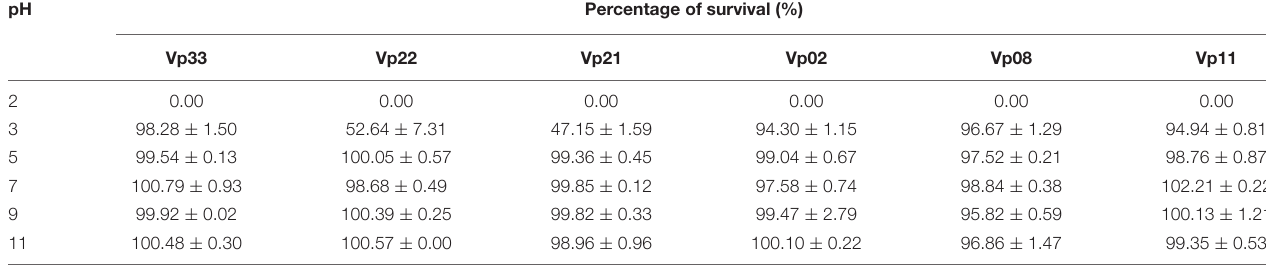
TABLE 5 | pH stability of bacteriophages.